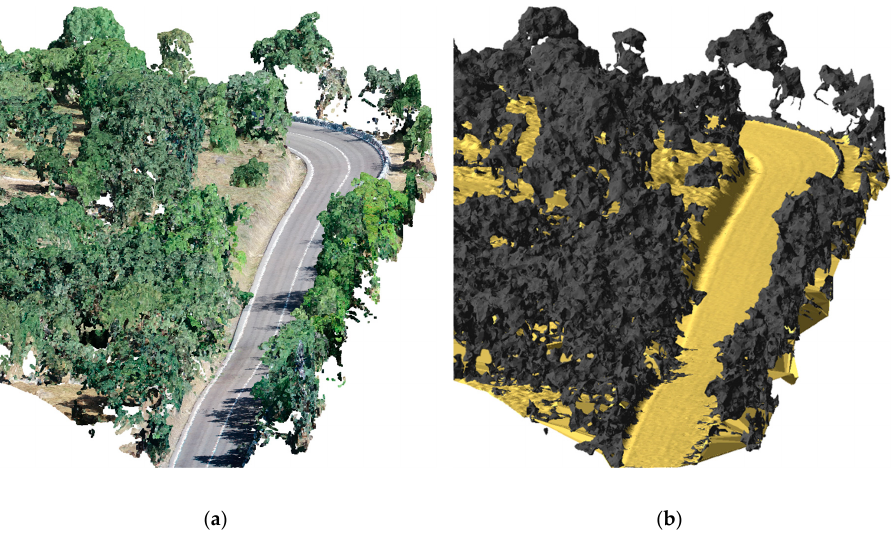
Figure 4. ( a ) Piece of the dense point cloud, and ( b ) counterpart 3D road environment model, where the TIN is displayed in yellow and the 3D objects in dark grey. the TIN is displayed in yellow and the 3D objects in dark